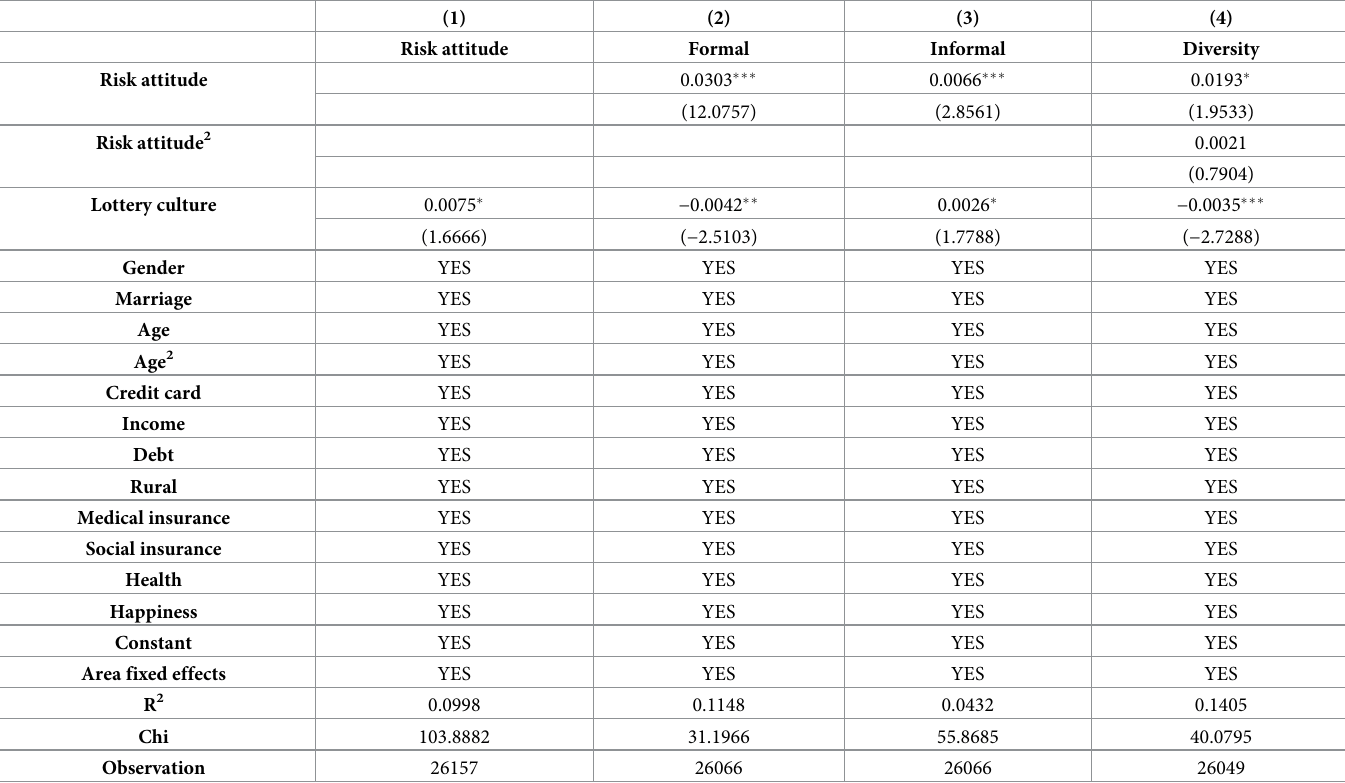
Table 5. “Lottery culture,” risk attitude, and household financial